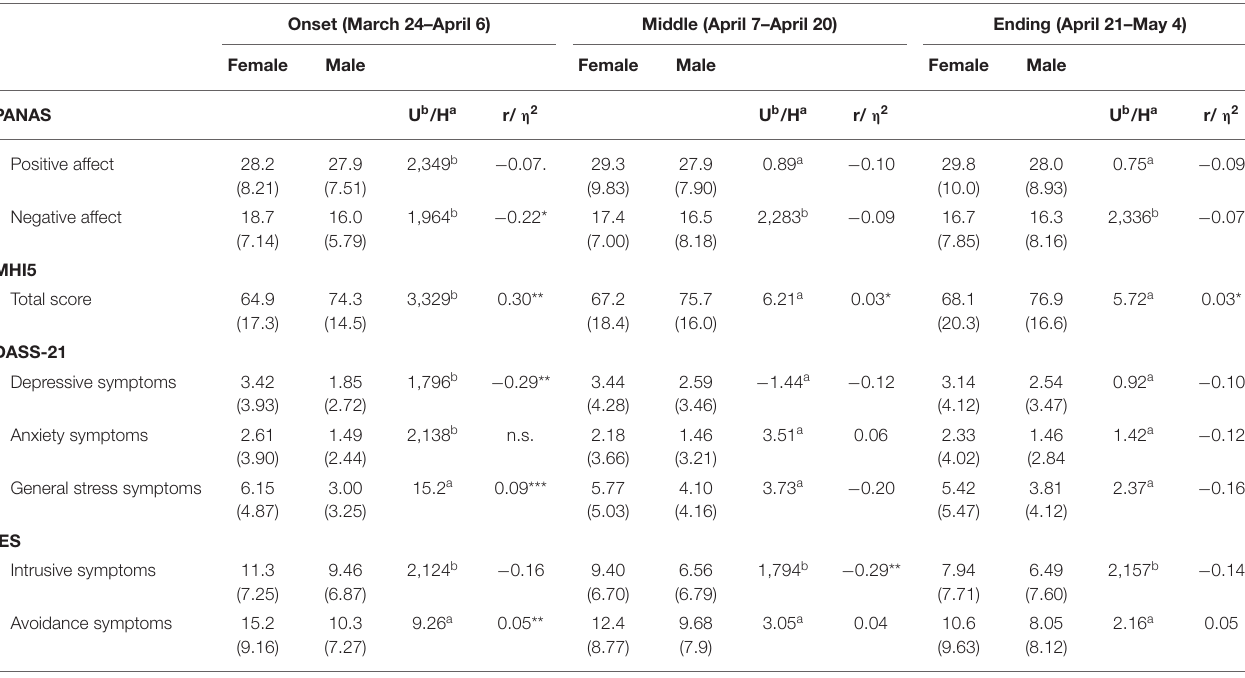
TABLE 3 | Comparison between female and male groups on the psychological measures in the first, second, and third